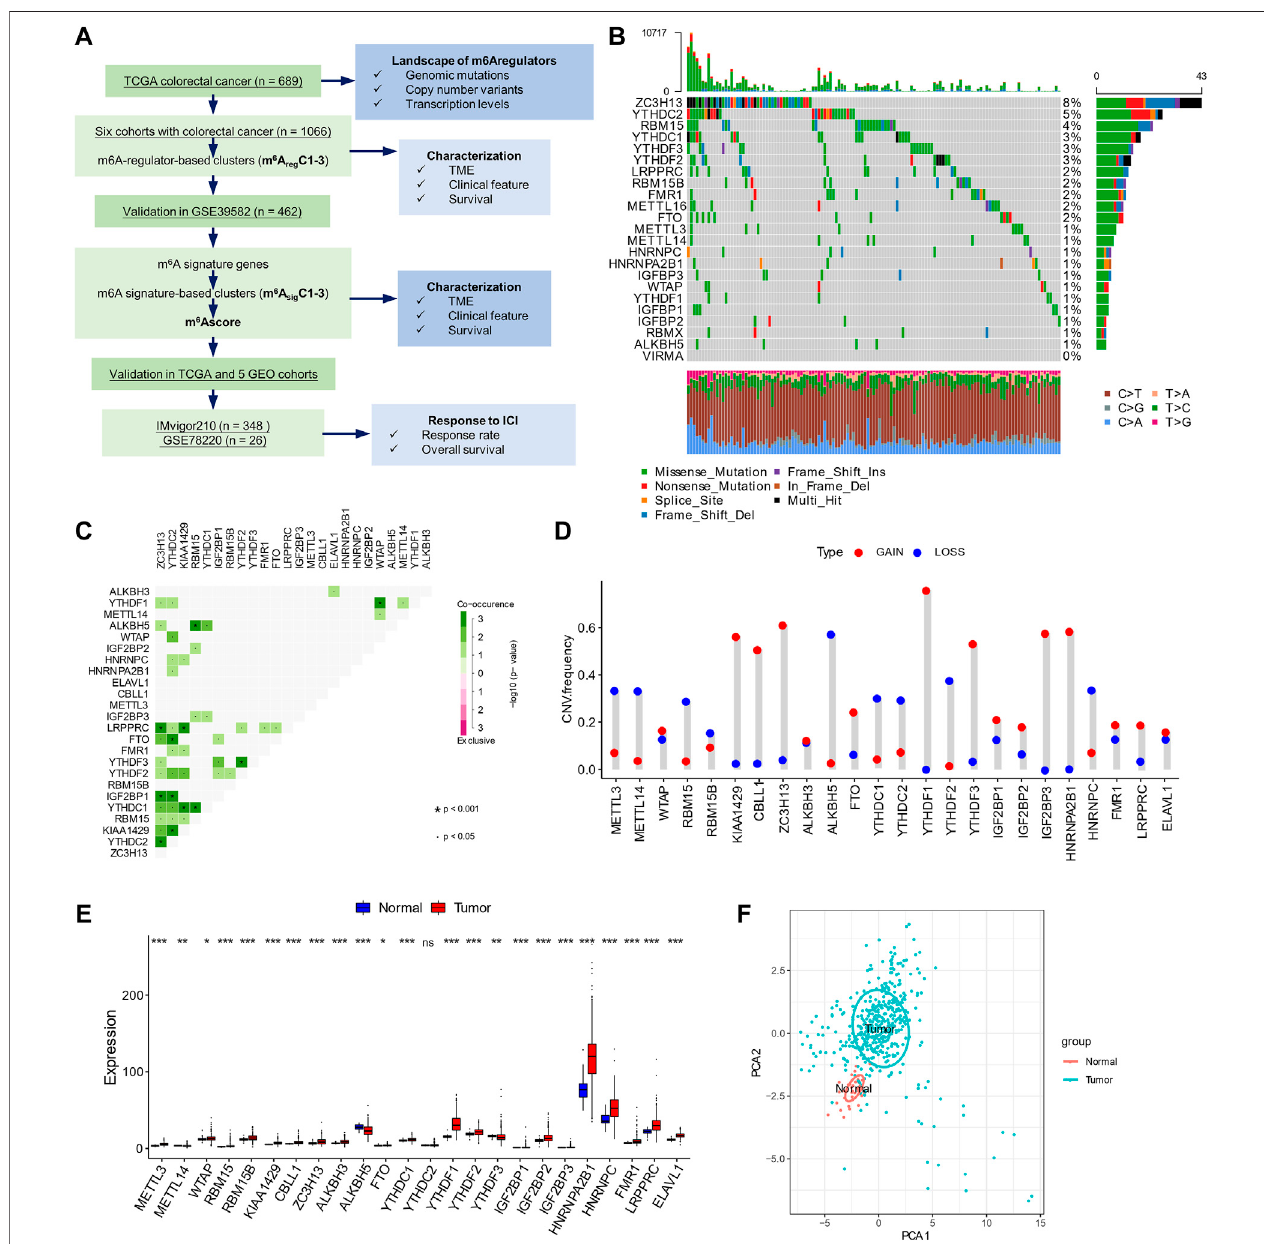
FIGURE 1 | Work fl ow and landscapes of m 6 A regulators. (A) Work fl ow chart of this study with the main process. Cohorts used in this study are underlined. (B) Mutation rates of m 6 A regulators in The Cancer Genome Atlas (TCGA) data set. (C) Mutation co-occurrence analysis of m 6 A regulators in the TCGA data set. Co- occurrences with statistical signi fi cance ( p < 0.05 and < 0.001) are shown. (D) Copy number variants in the TCGA data set. (E) Expression levels of m 6 A regulators in normal and tumor tissues. (F) Principal component analysis for RNA level of 24 m 6 A regulators in the TCGA data set. * p < 0.05; ** p < 0.01; *** p <